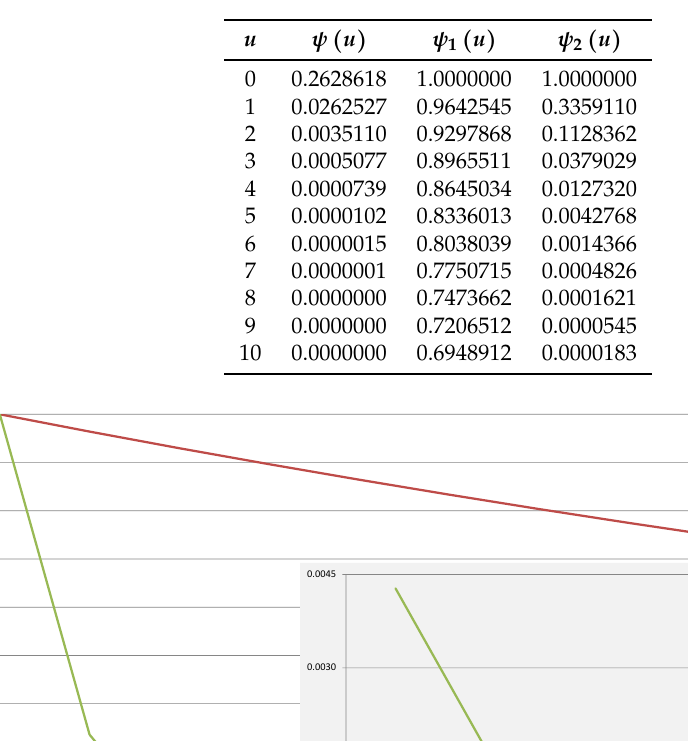
Table 2. Values and estimates of ruin probability for model of Example 2.